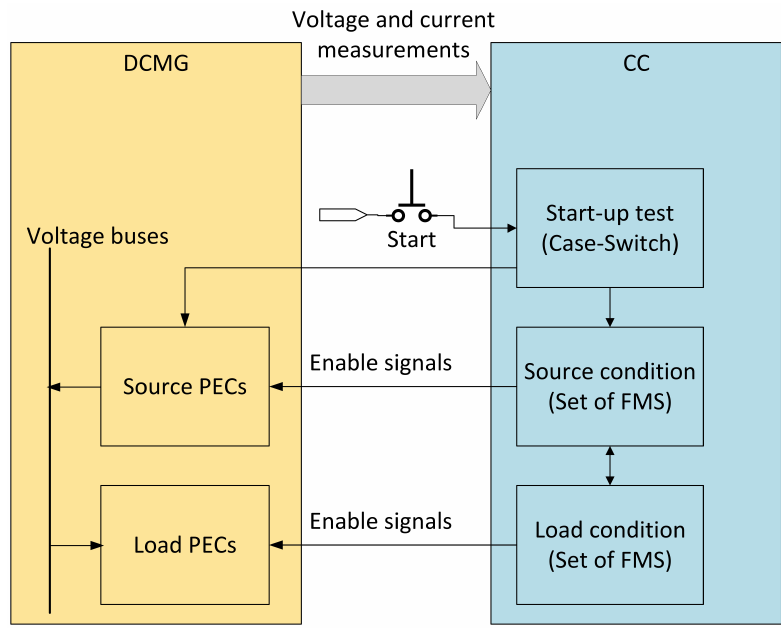
Figure 12. EMS stages block